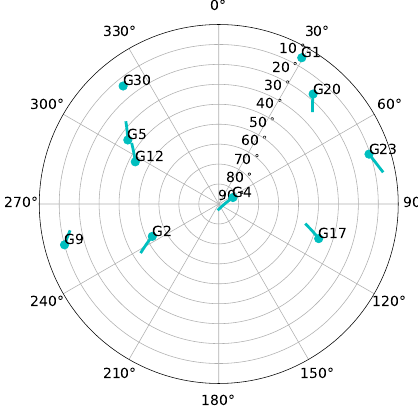
Figure 8. Sky-plot of the simulated